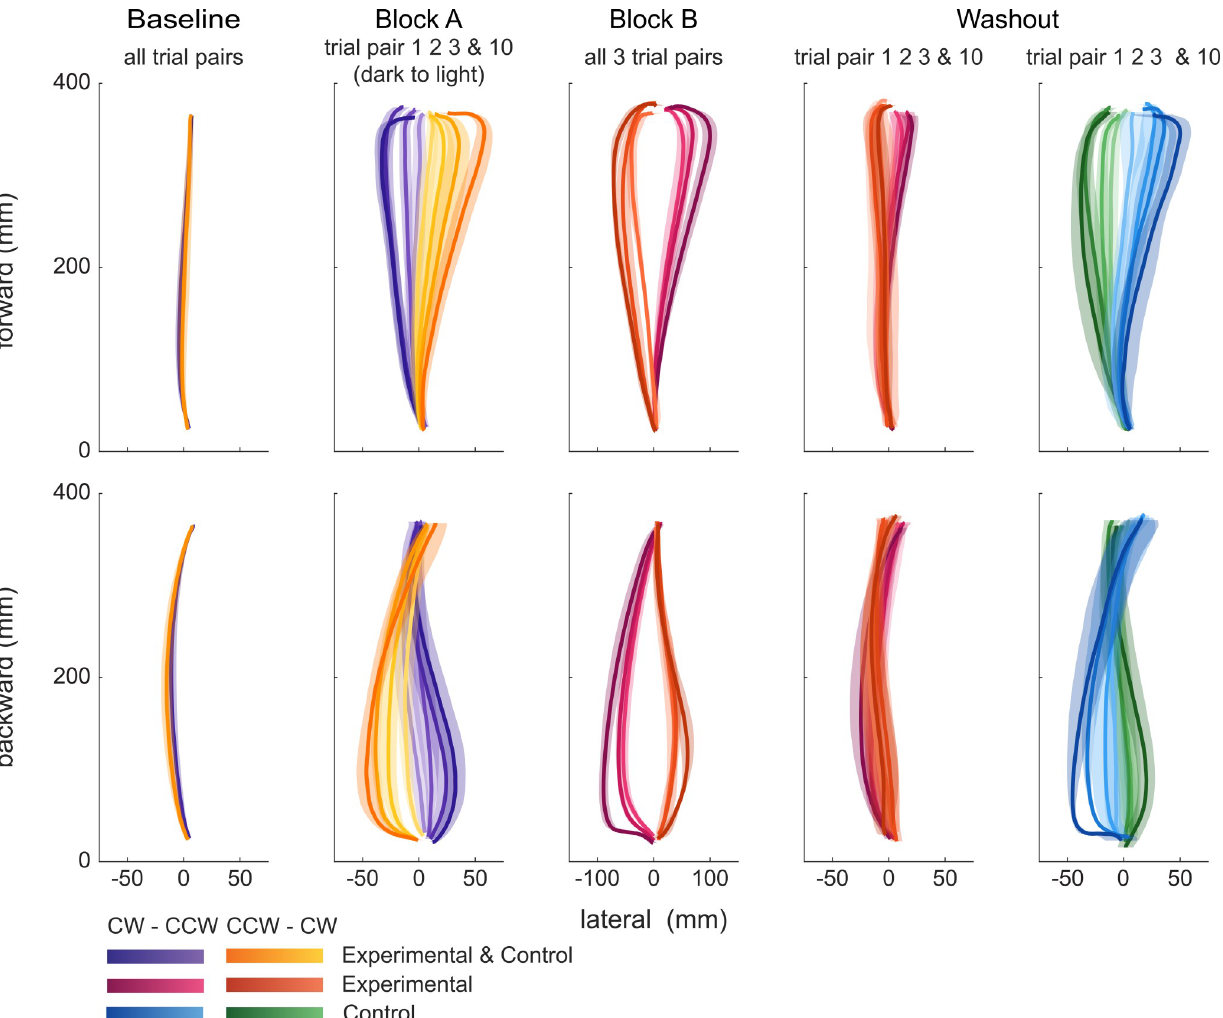
Fig 2. Reach trajectories at different phases of the paradigm. CW-CCW groups, cooler colors (i.e. purple, magenta and blue); CCW-CW group; warmer colors (i.e. ochre, orange and green). Top row, forward reaches; bottom row, backward reaches. Baseline: grand-average of all trials of control and experimental group. Block A: Across-participant average of forward and backward reaches in trial pair 1, 2, 3, and 10 of the block (i.e. trial pairs 46, 47, 48, and 55 of the paradigm), ordered from darker to lighter hues. Block B: Across-participant average of each of the three forward and backward reaches, ordered from darker to lighter hues. Washout: Across-participant average of forward and backward reaches in trial pair 1, 2, 3, and 10 of the block, in separate panels for the control and experimental group.